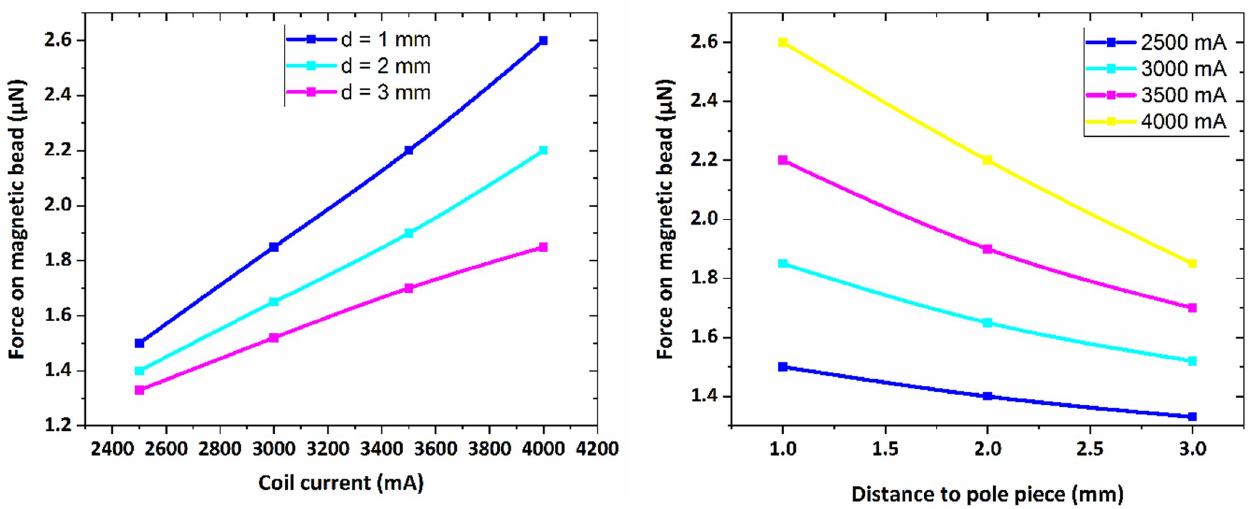
Fig 5. The graph of magnetic force versus coil electric current for distances of 1–3 mm from pole piece for the bead of 1000 μ m.